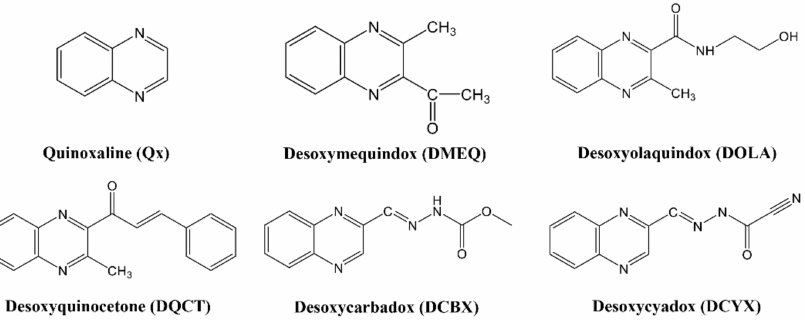
Figure 1. The chemical structures of Qx and the major